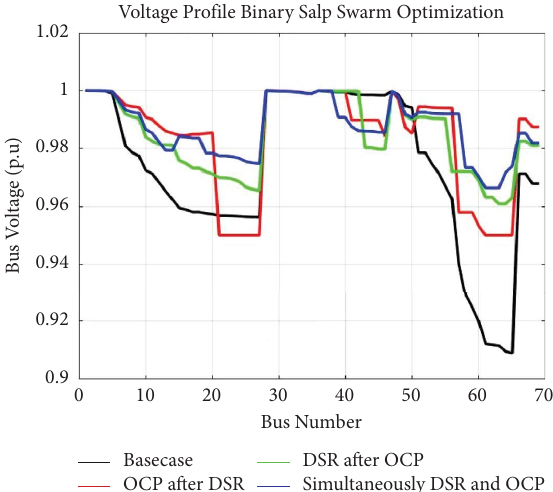
Figure 17: Voltage profle for 69-bus using BSSA algorithm for three scenarios with the base case.